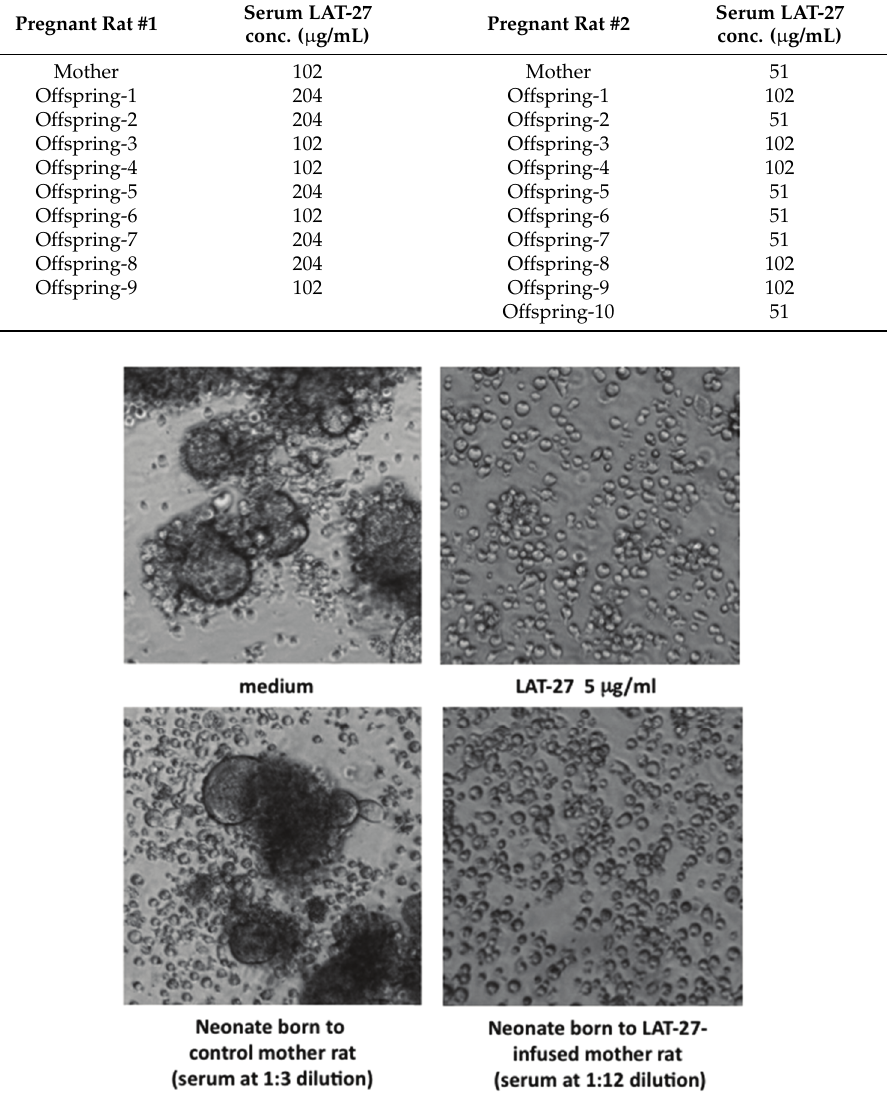
Figure 1. Neutralization of HTLV-I by mother-to-offspring-transferred LAT-27. Syncytium inhibition assay was carried out as described in Materials and Methods. ILT-M1 cells were treated with diluted serum or purified antibody in a flat-bottom 96-well micro-titer plate for 5 min, and then co-cultured with Jurkat cells. After cultivation for 16 h, syncytium formation was microscopically observed using an inverted microscope at magnification of 200×.